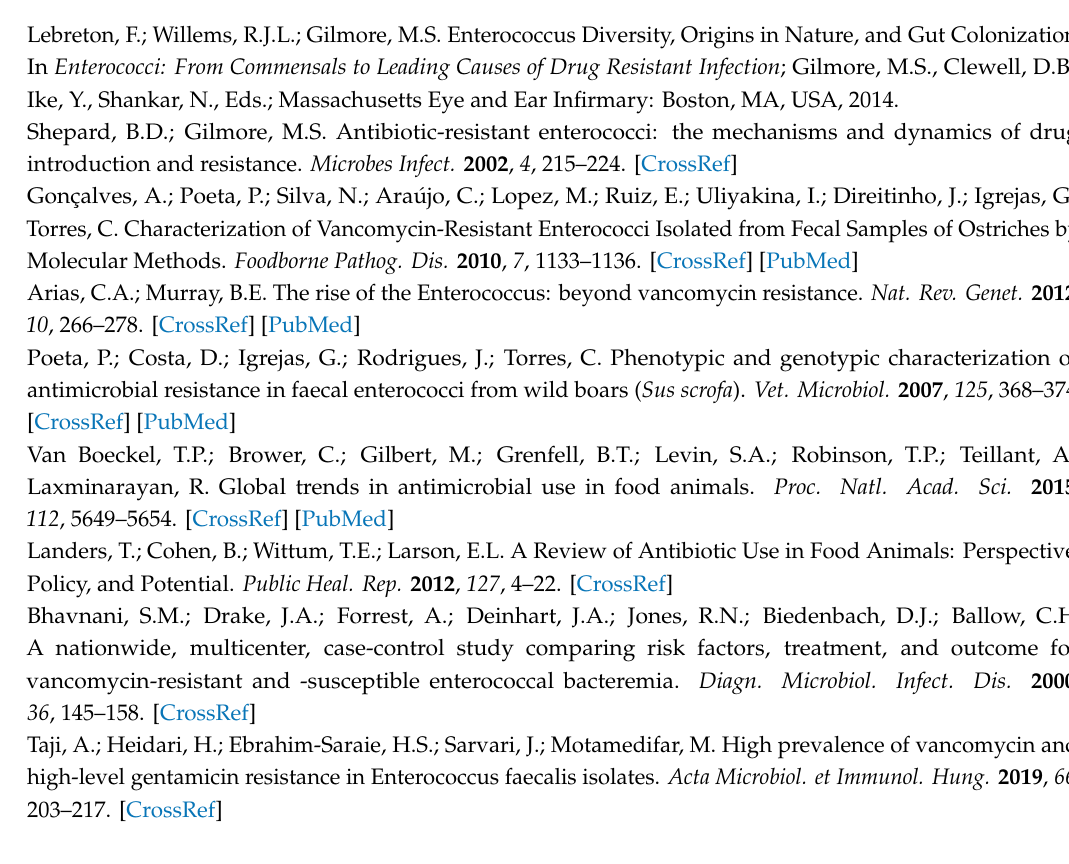
Table S1: Exclusive masses found for each